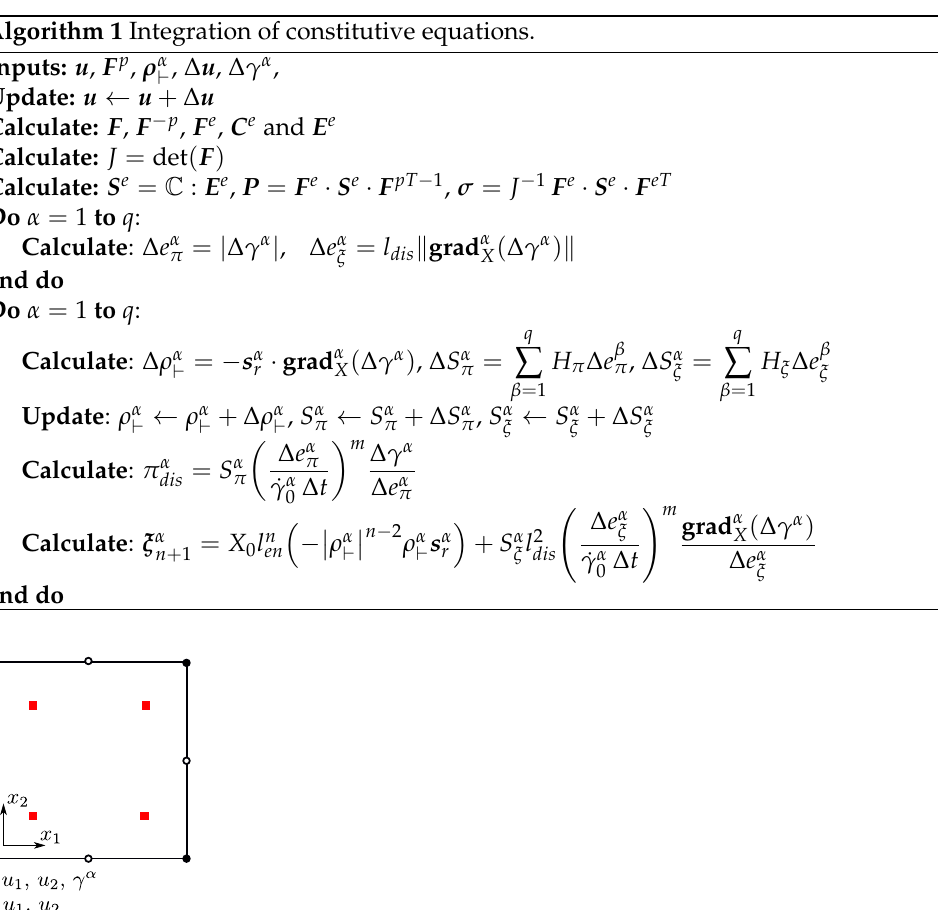
Algorithm 1 Integration of constitutive equations.